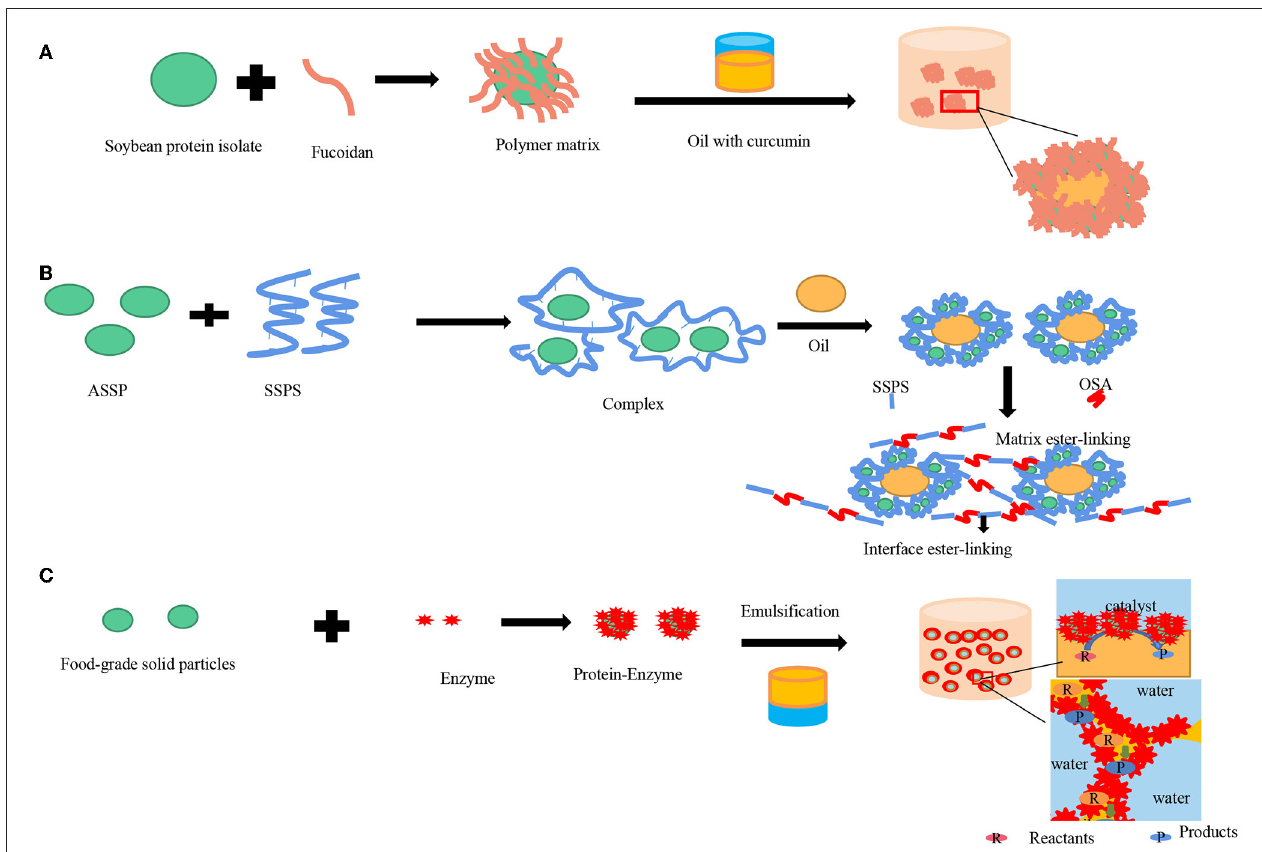
FIGURE 5 | Pickering emulsions applied in foods fields. (A) Encapsulation of curcumin; (B) Food packaging film preparation; (C) Pickering emulsion catalytic efficiency improving.